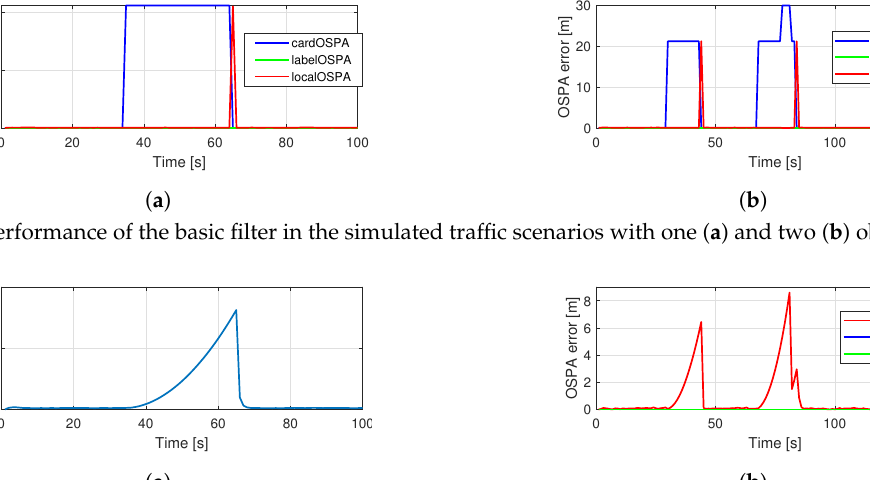
performance of the proposed filter is shown in Figure 13. In this case, no cardinality error occurs, and the localization error increases gradually as the estimation becomes more uncertain during occlusion. The actual scaling of the cardinality error depends on the cutoff distance, hence the information gain manifested through the correct cardinality estimates should be tuned via this parameter.